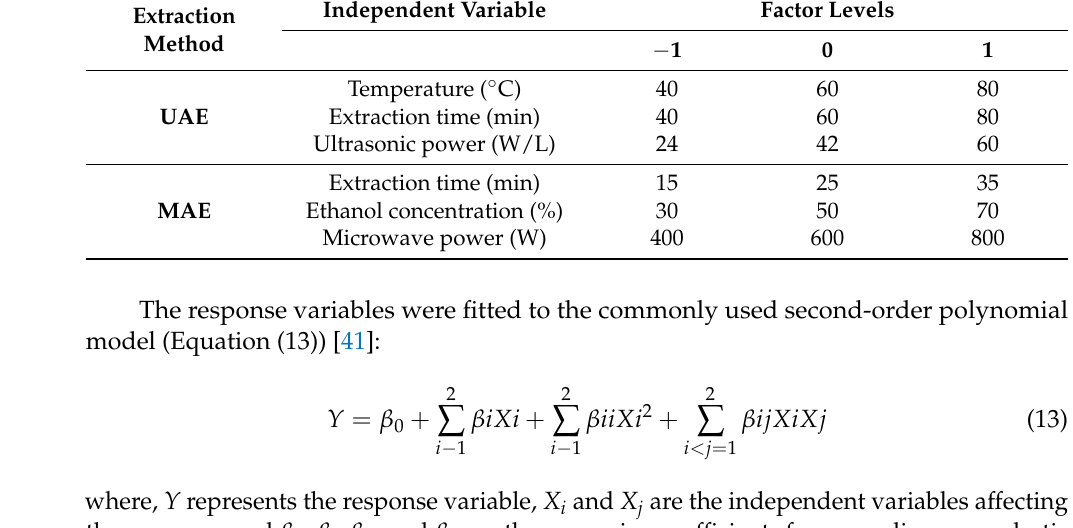
Table 7. Experimental domain with natural and coded values of independent variables.